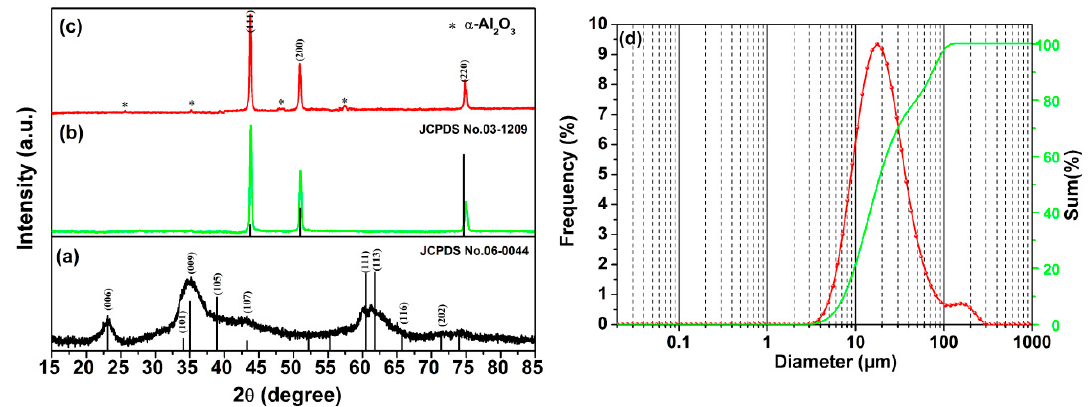
Figure 4 . XRD patterns: ( a ) Mixture metal oxides, ( b ) prealloy powder reduced at 973K and ( c ) spherical alloy powder fabricated at 1823 K, ( d ) particle size distribution of spherical Fe 50 Ni 50 alloy powder.